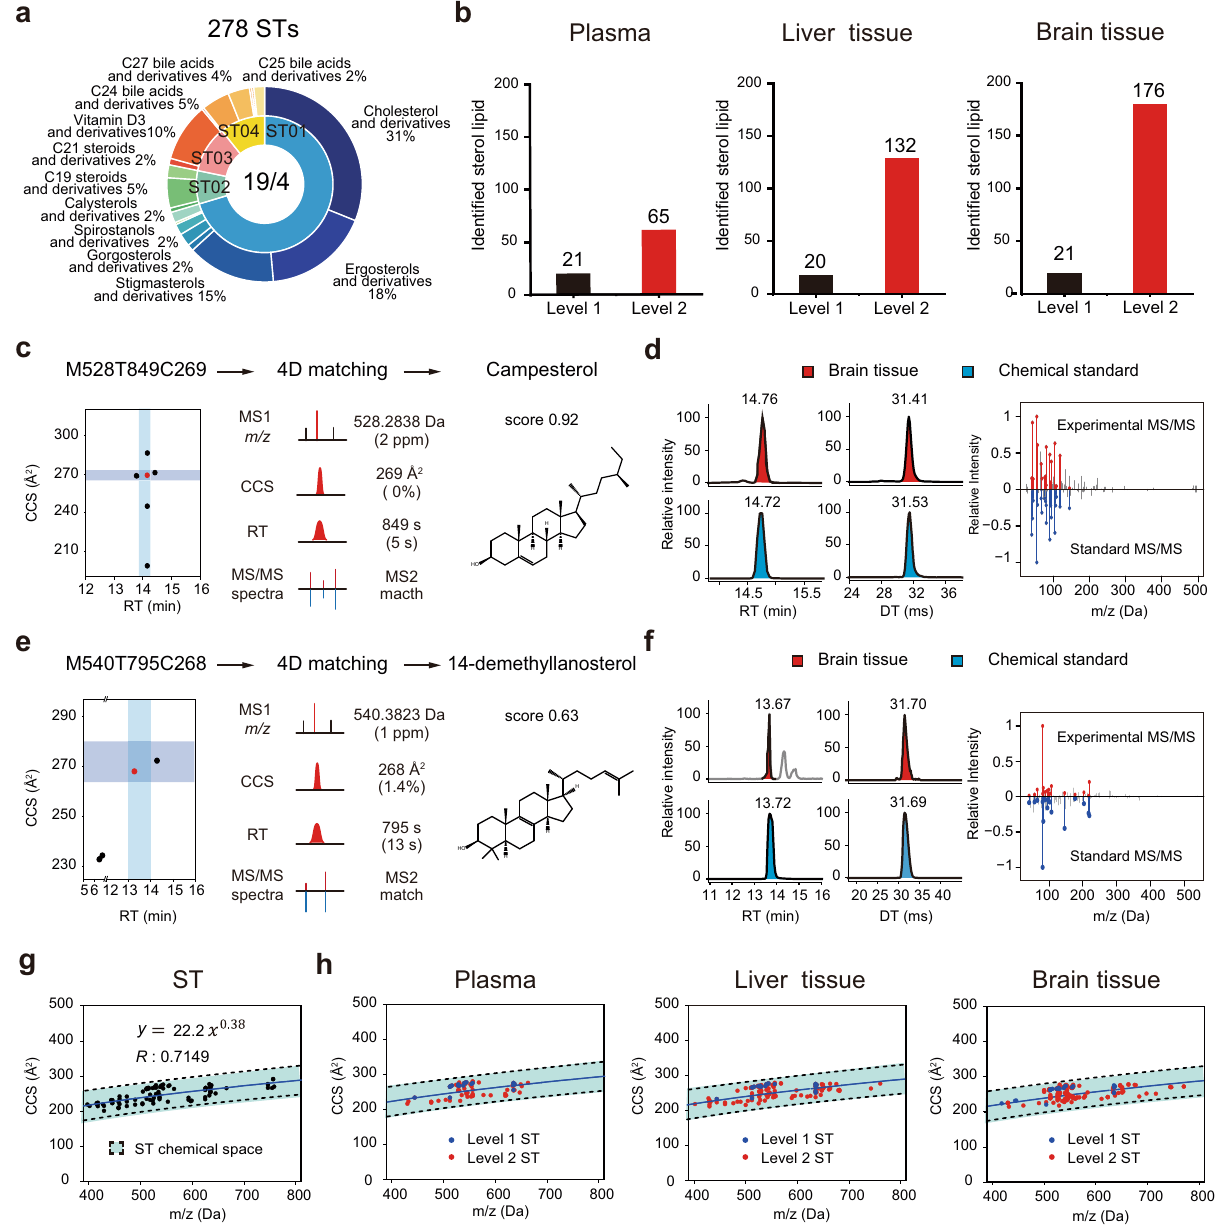
Fig. 4 IM-MS-based four-dimensional sterol lipid analysis of biological samples. a Subclass statistical analyses of the identi fi ed sterol lipids in human plasma ( n = 3 technically replicated samples), mouse liver tissue ( n = 6 biologically independent samples), and mouse brain tissue ( n = 6 biologically independent samples for each group). Each sample was analyzed once by LC-IM-MS. b Numbers of identi fi ed sterol lipids with MSI level 1 and MSI level 2 in three sample types. c The identi fi cation of campesterol in brain tissue samples using the standard ST library through four-dimensional matching. d Validation of campesterol identi fi cation with the chemical standard. e The identi fi cation of 14-demethyllanosterol in brain tissue sample using the extended ST library through four-dimensional matching. f Validation of the 14-demethyllanosterol identi fi cation with the chemical standard. g Fitted trend line and chemical space for sterol lipids as determined using a power function with the standard ST library ( n = 97). h The distributions of the identi fi ed sterol lipids from three sample types in the chemical space of sterol lipids. Blue solid line, the trend line of sterol lipids. Black dash lines, the 99% predictive